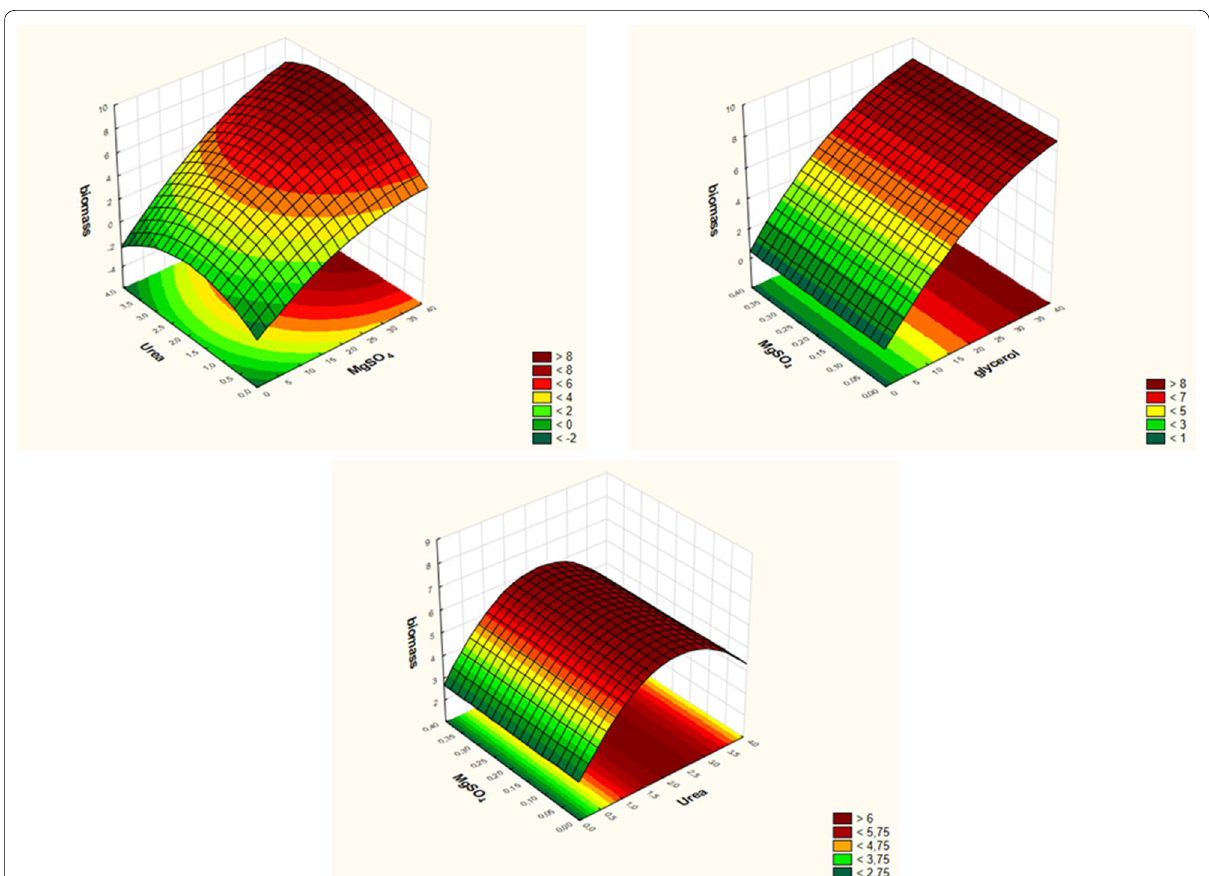
Fig. 1 Response surface plots showing the effects of (x 1 ) crude glycerol, (x 2 ) urea and (x 3 ) magnesium sulfate on (Y) biomass concentration